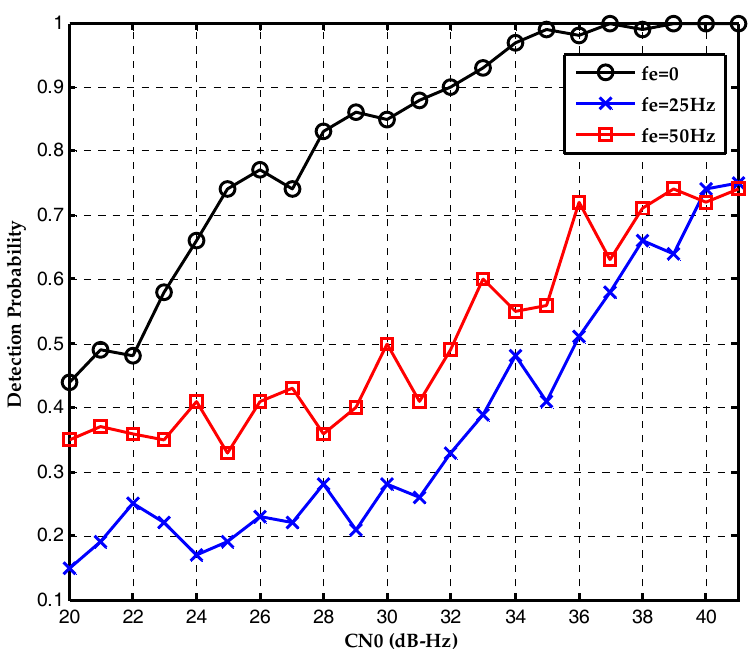
Figure 10. Detection probabilities of the DCML bit synchronization algorithm under the CN0s of 20~40 dB-Hz and different frequency deviations.